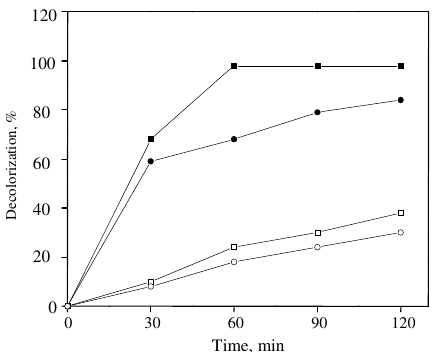
Figure 7 . Comparison of the effect of UV and sunlight on the decolorisation of Reactive Red 120: C = 5 mg/L, .( ■ ) 0 UV/TiO , ( ● ) SL/TiO , ,( □ ) UV, ( ○ ) SL 2 2